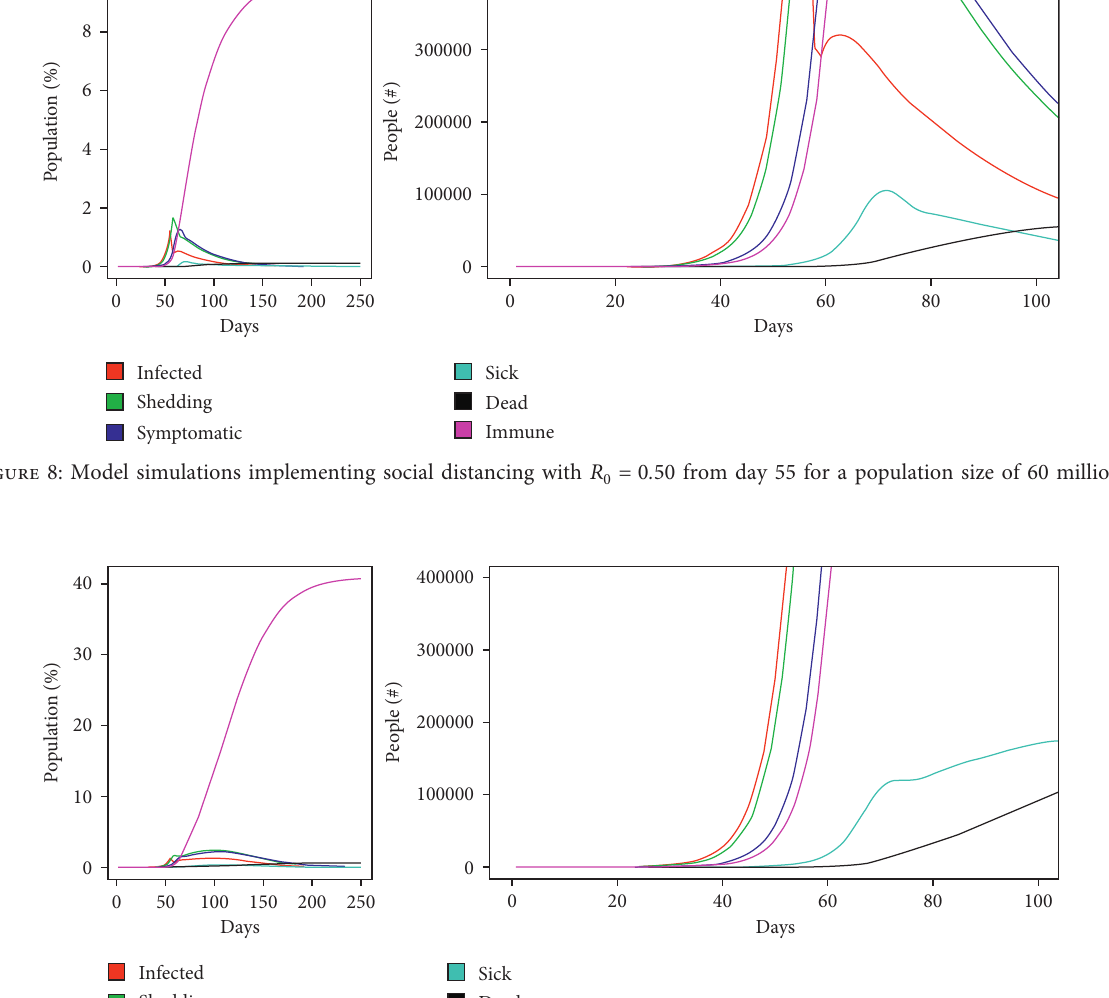
� 0 . 75 from day 55 for a population size of 60 0